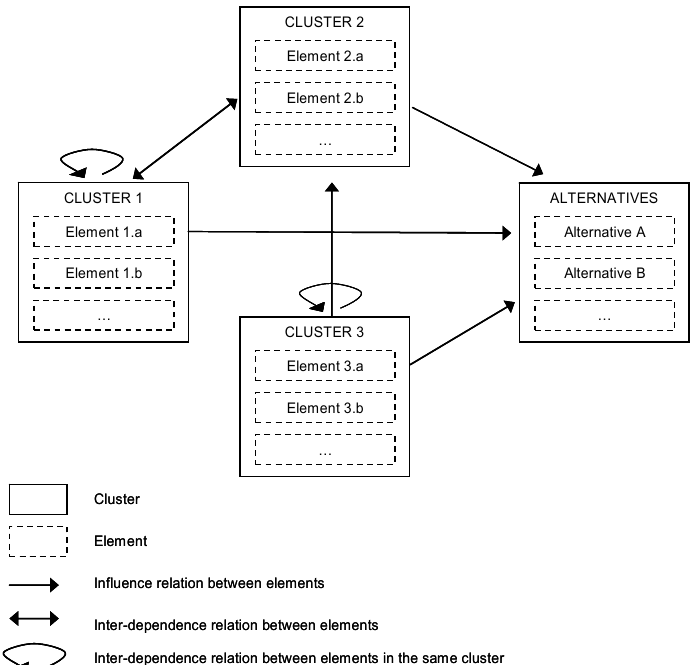
Figure 1. Network structure example (Bottero et al., 2007) .